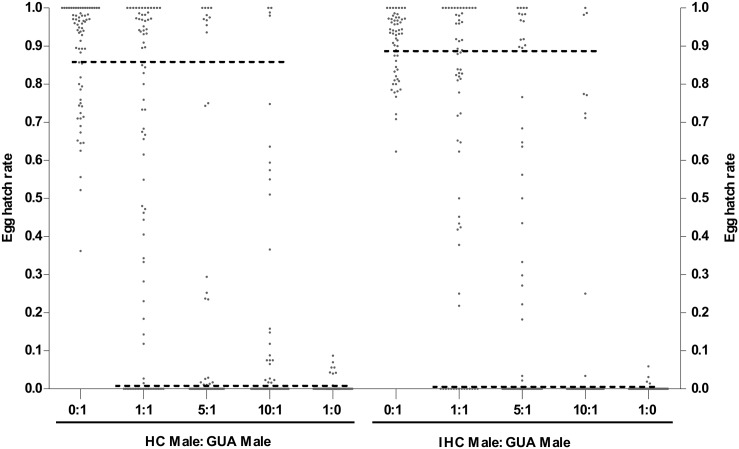
Distribution of egg hatch rates for individual GUA females recollected from experimental cages containing a 1:1, 5:1 or 10:1 ratio of sterile (HC or IHC males) to fertile GUA males, or from control cages containing only sterile or only fertile males in the small cages.The black solid line represents the lower SE of the mean egg hatch rate of either the fertile cages or higher SE of the mean in sterile cages. These limits were used to assign egg batches from competitiveness treatments to either sterile or fertile mating events. Egg batches of an individual female with a hatch rate between the lower SE of the fertile cages and the higher SE of the sterile cages were defined as being intermediate—from an indeterminate mating event.